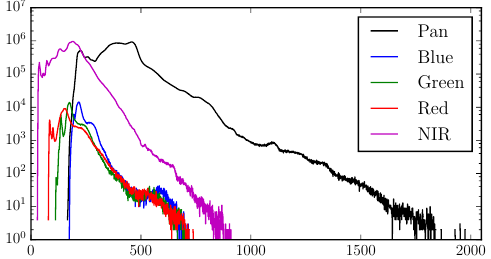
Figure 4: Histograms of panchromatic and multispectral channels of all images in the Fos sur Mer scene.